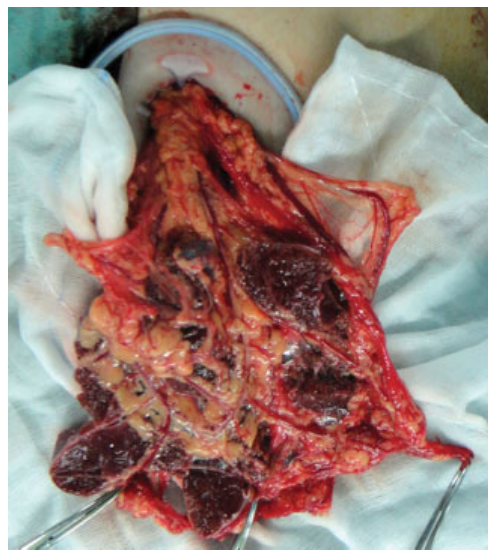
Fig. 2 Splenic tissues were transplanted into pouches created in the omentum through the single umbilical incision. European Journal of Pediatric Surgery